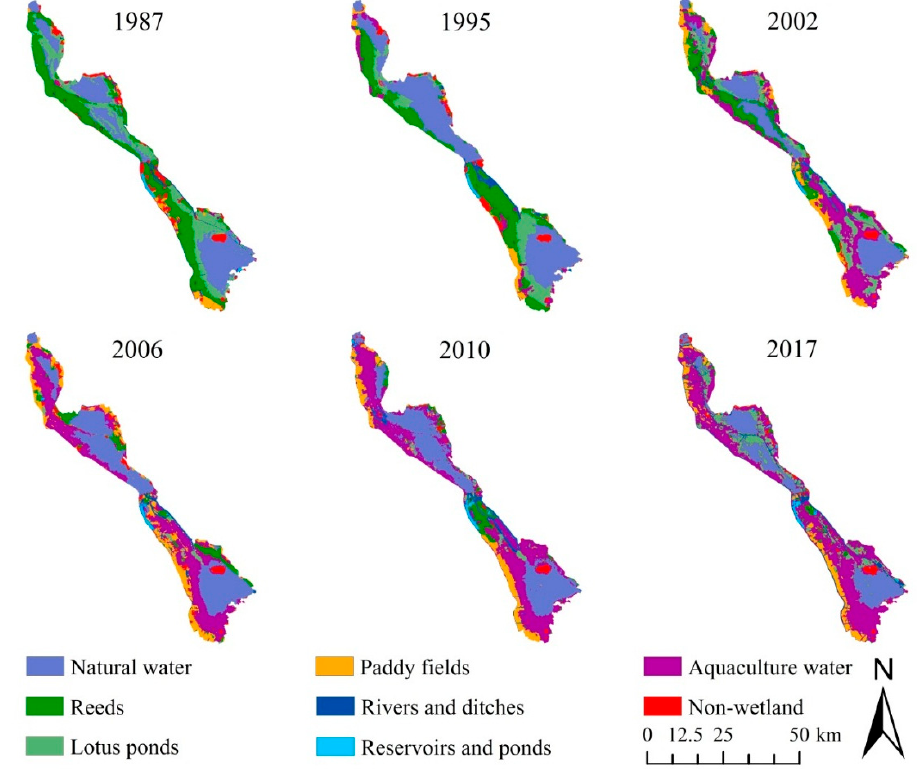
Figure 2. The current land use maps of Nansi Lake wetland from 1987 to 2017.